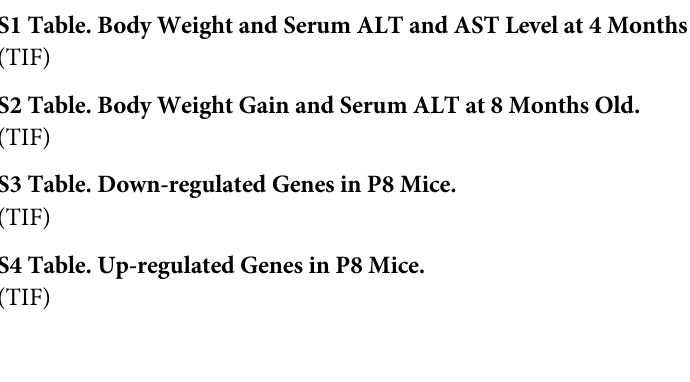
S1 Table. Body Weight and Serum ALT and AST Level at 4 Months Old. S2 Table. Body Weight Gain and Serum ALT at 8 Months Old. S3 Table. Down-regulated Genes in P8 Mice. S4 Table. Up-regulated Genes in P8